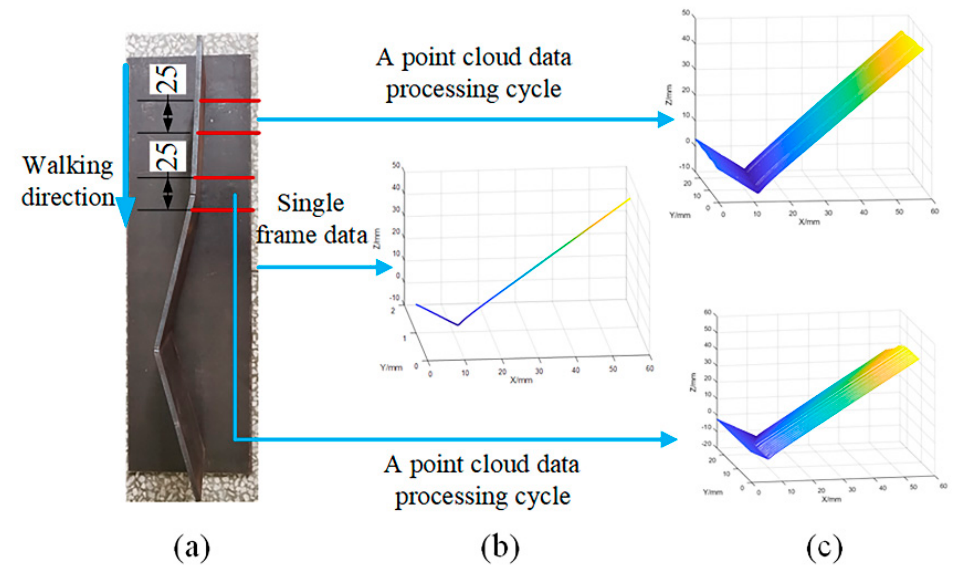
Figure 2. 3D zigzag-line welding seam point cloud data; ( a ) Workpiece; ( b ) Single frame data; ( c ) Point cloud data